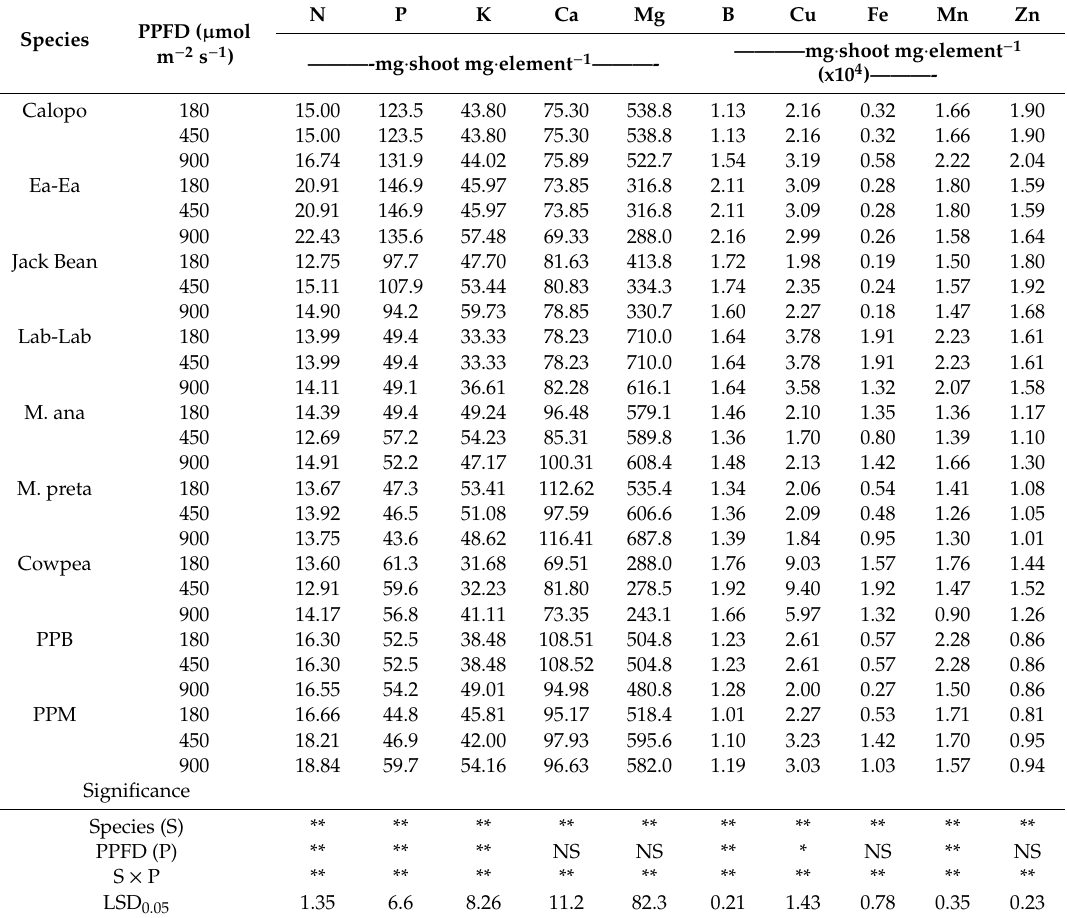
Table 7. E ff ect of photosynthetic photon flux density (PPFD) on nutrient use e ffi ciency (NUE) in cover